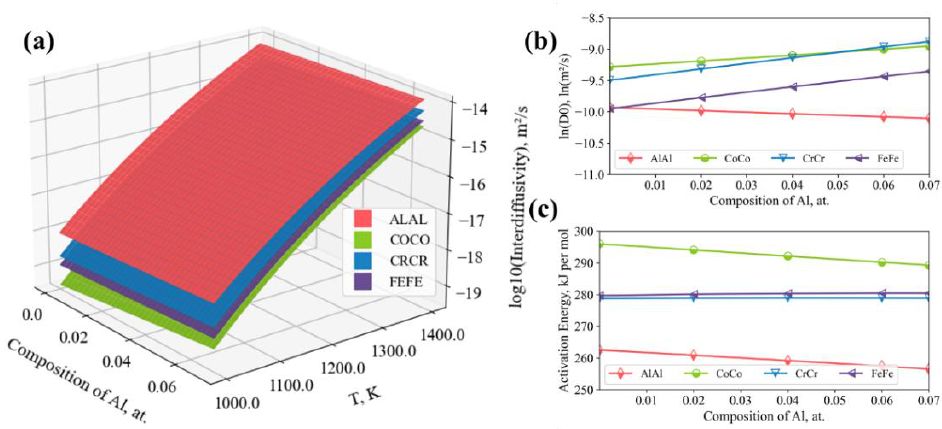
Figure 5. Influence of aluminum content on the main terms of the interdiffusivity matrices of the Alx(CoCrFeNi)1-x alloys: ( a ) Surface plot for interdiffusivites; ( b ) Pre-frequency factors of Arrhenius relation; ( c ) Activation energies of the Arrhenius relation, where ALAL stands for (cid:101) D Ni CoCo , CRCR for (cid:101) D Ni CrCr and FEFE for (cid:101) D Ni FeFe .